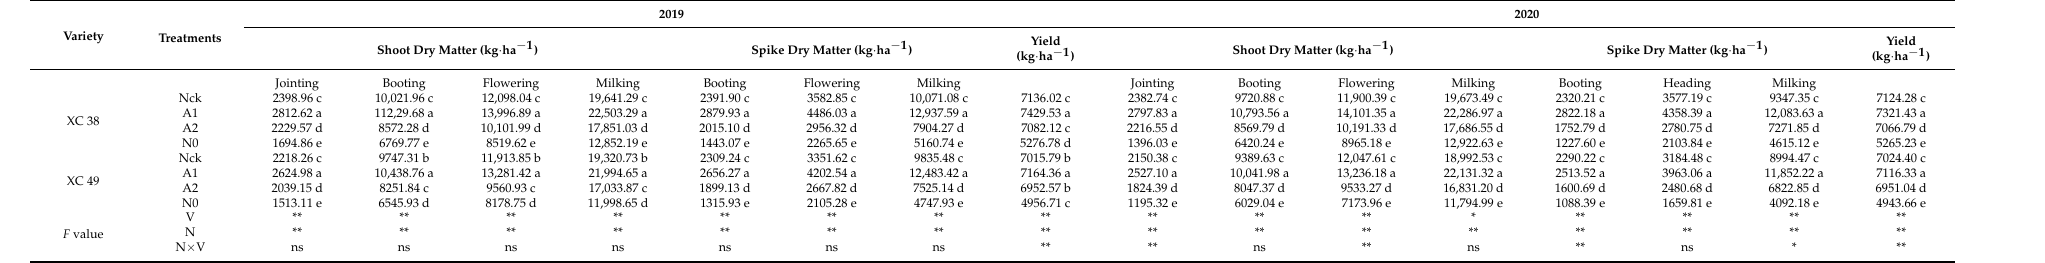
Table 5. Effect of nitrogen supply on shoot dry matter and spike dry matter of